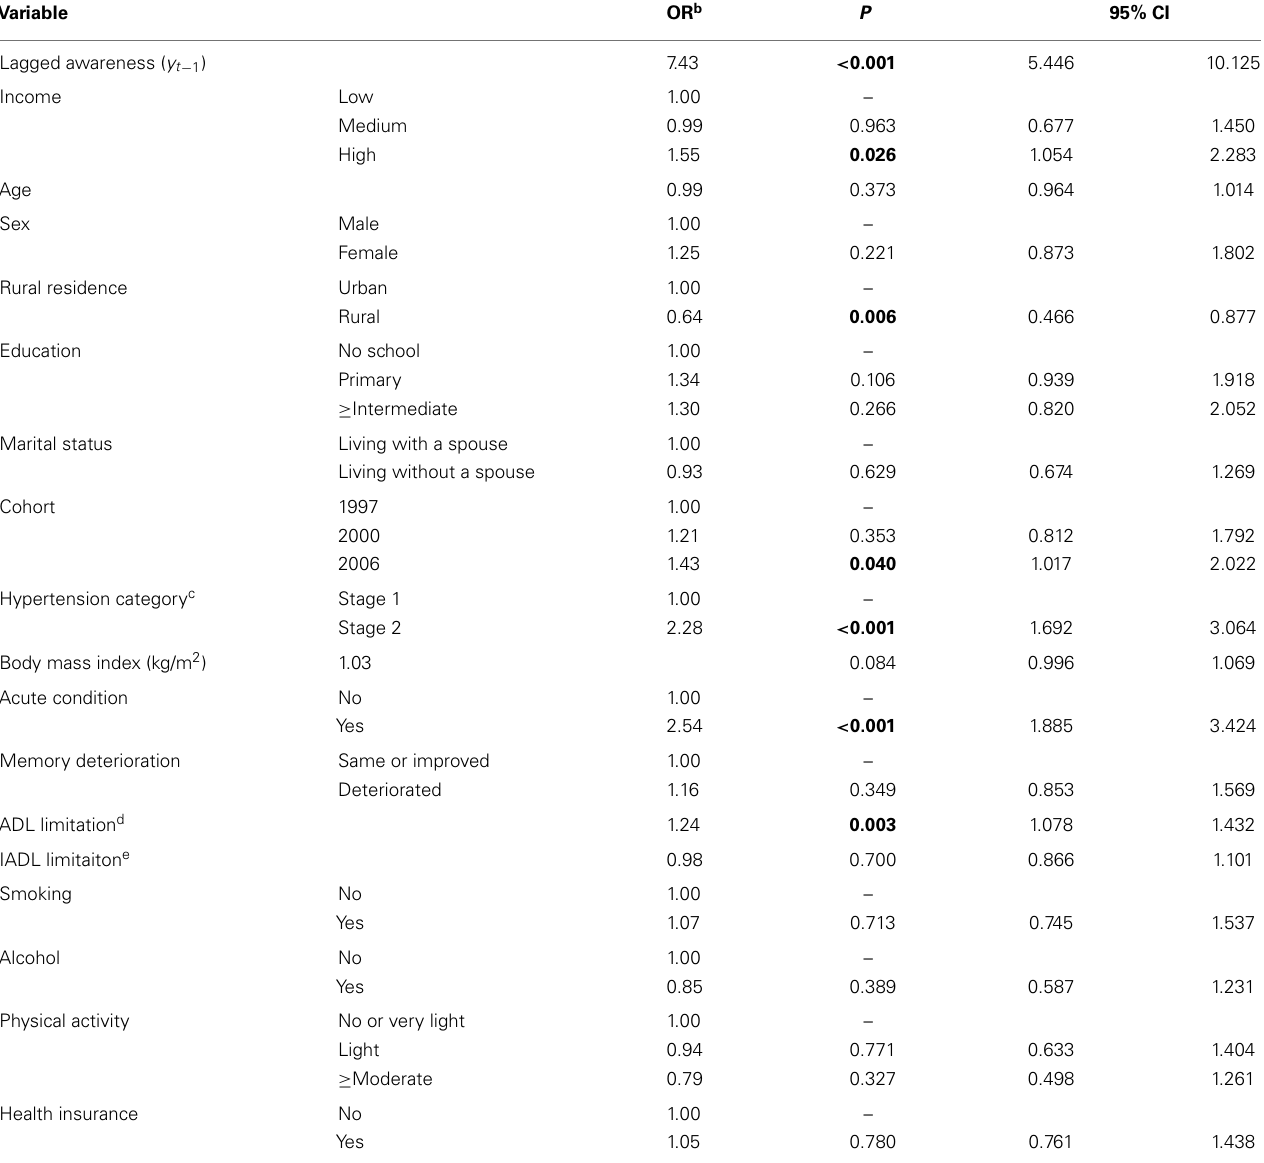
Table 2 | Factors associated with hypertension awareness in older Chinese adults ( n = 849) a .